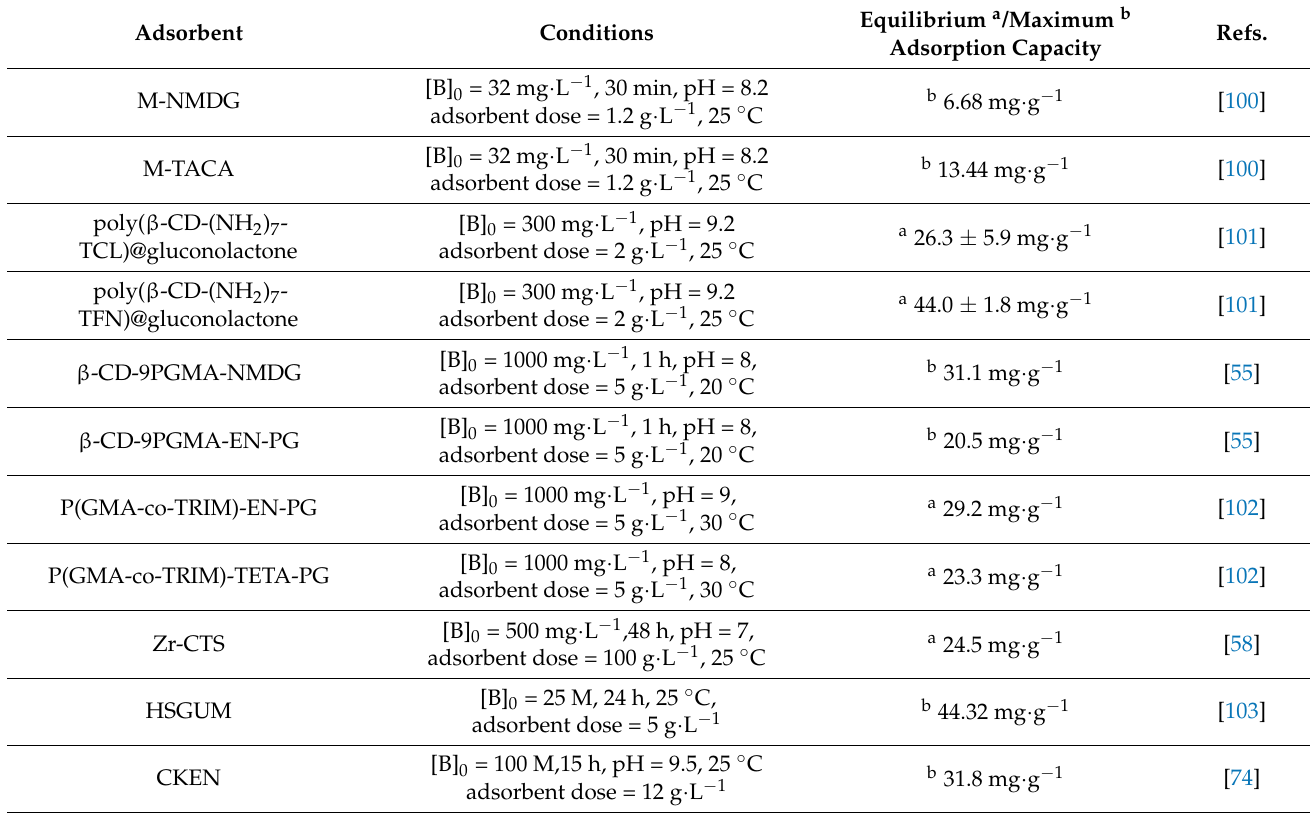
Table 15. Boron removal performances of new material